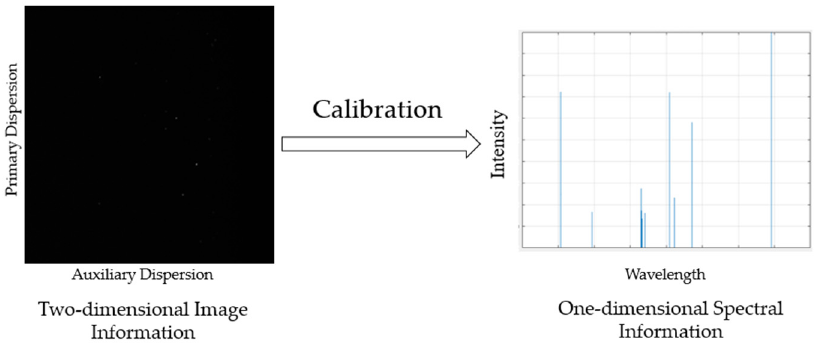
Figure 8. Calibration diagram.